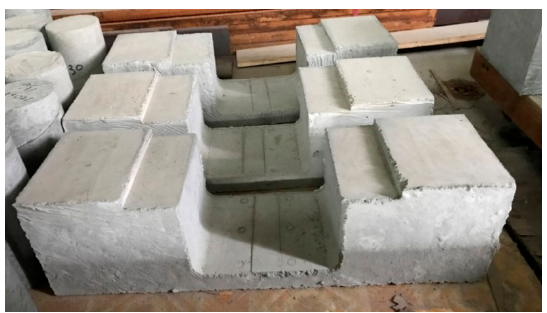
Figure 8. Cured strut-and-tie beam specimen.